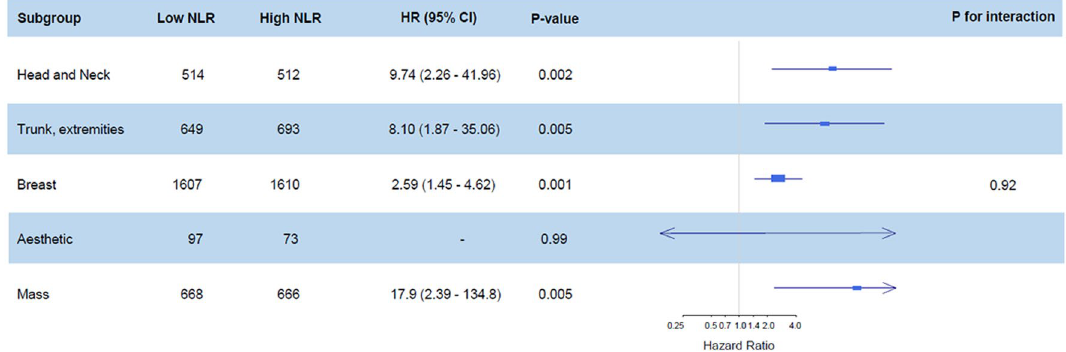
Figure 3. Subgroup analysis according to types of plastic and reconstructive surgery.